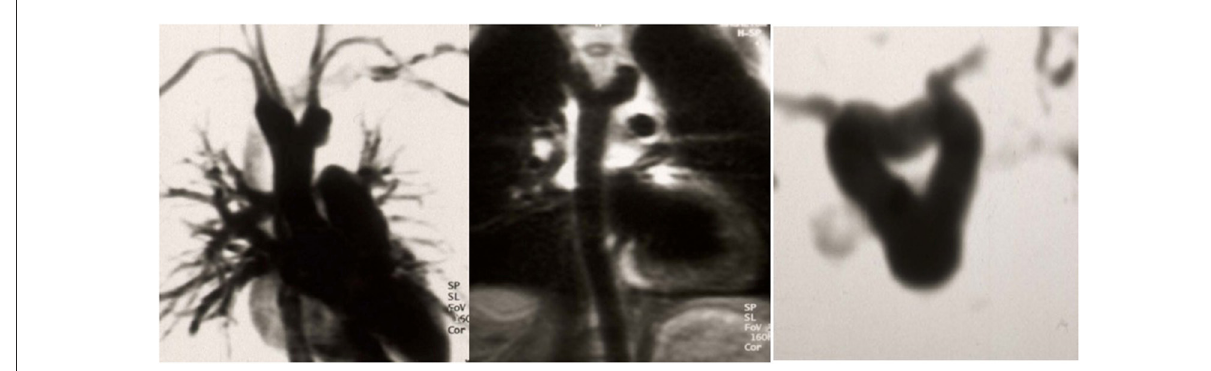
FIGURE3 Left: Balanced double aortic arch with each arch giving origin to a subclavian and a carotid artery Middle: confluence in the posterior mediastinum into a single descending aorta. Right: Complete immurement of the trachea and the esophagus within the vascular ring. Reproduced with permission from Schweiz. Med. Wschr. 1999; 129:1722.